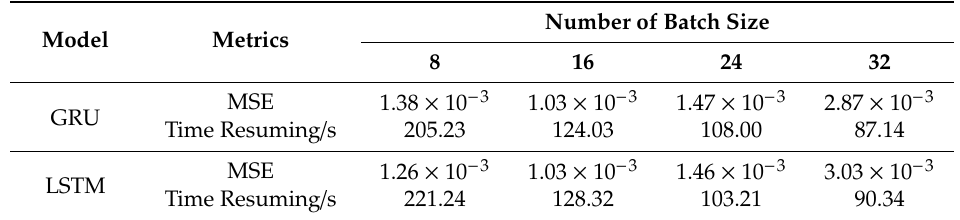
Table 2. Comparison of the experimental influence of di ff erent parameters of batch size on the two models.